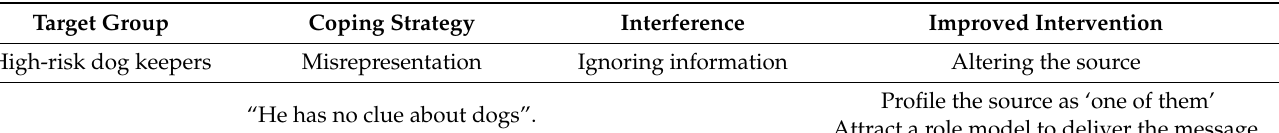
Table 1. Example of an improved intervention for a target group to preempt interference by a coping strategy. Target Group Coping Strategy Interference Improved Intervention High-risk dog keepers Misrepresentation Ignoring information Altering the source Profile the source as ‘one of them’ “He has no clue about dogs”. Attract a role model to deliver the